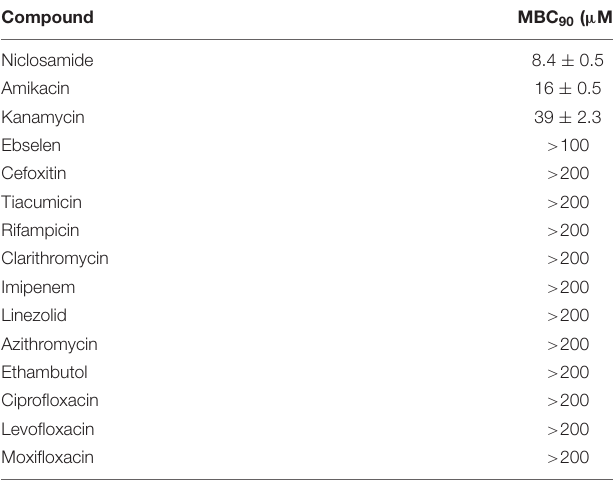
TABLE 1 | Activity of drugs against non-replicating M. abscessus . Compound